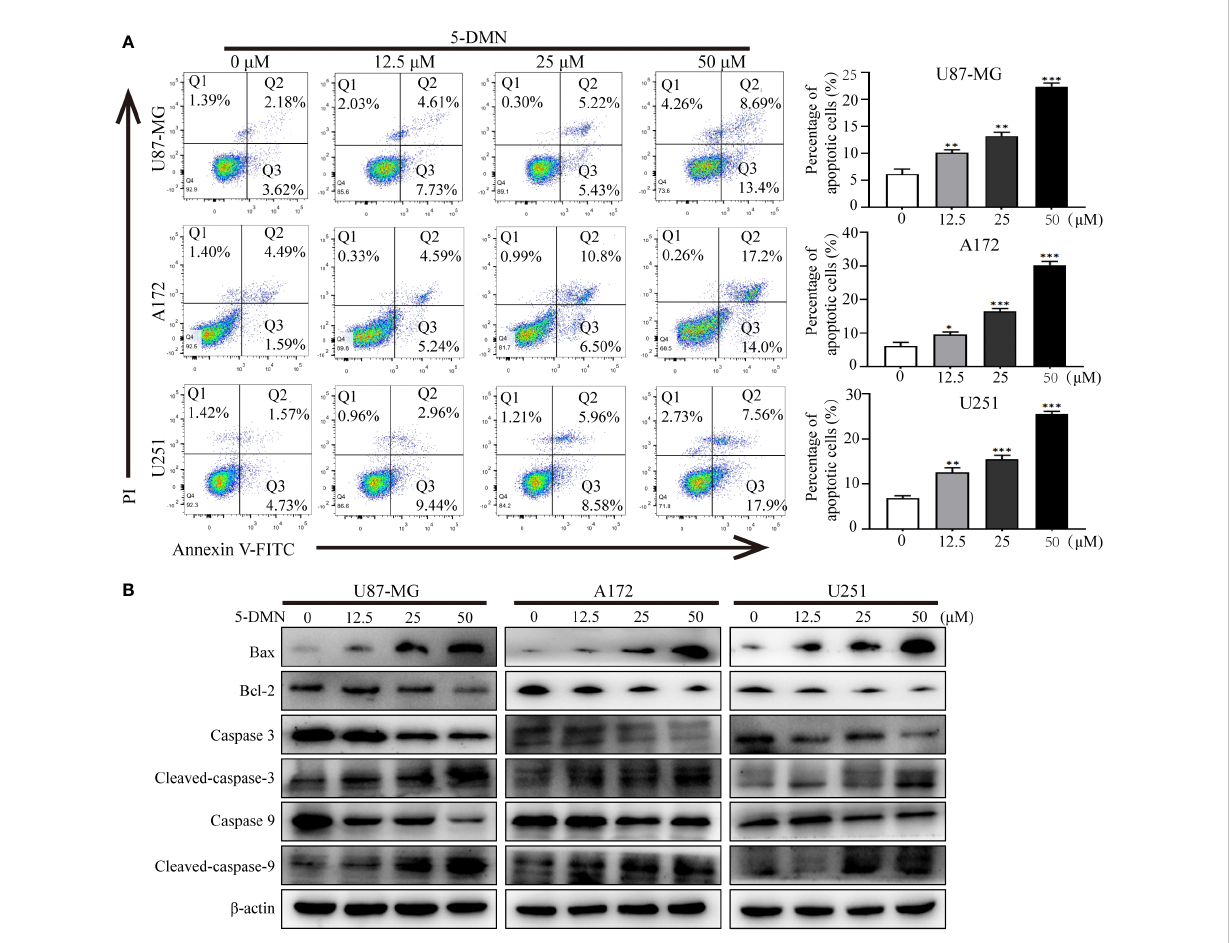
FIGURE 3 5-DMN induces GBM cells apoptosis. (A) The apoptotic rate of U87-MG, A172, and U251 cells after 5-DMN treatment was determined using double staining with Annexin V-FITC/PI. The histograms showed the percentage of apoptosis in three separate experiments. (B) Western blotting analysis